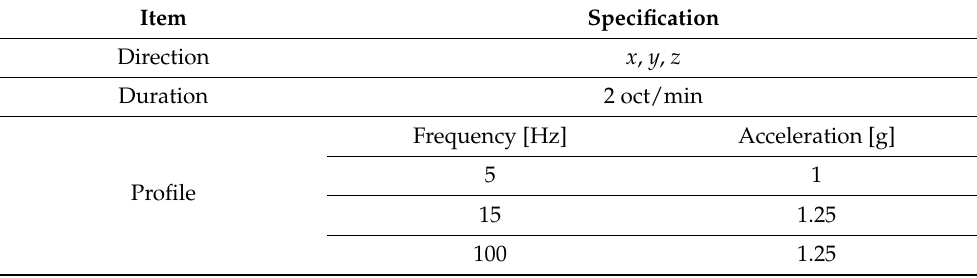
Table 5. Specification of the Random - vibration Test.